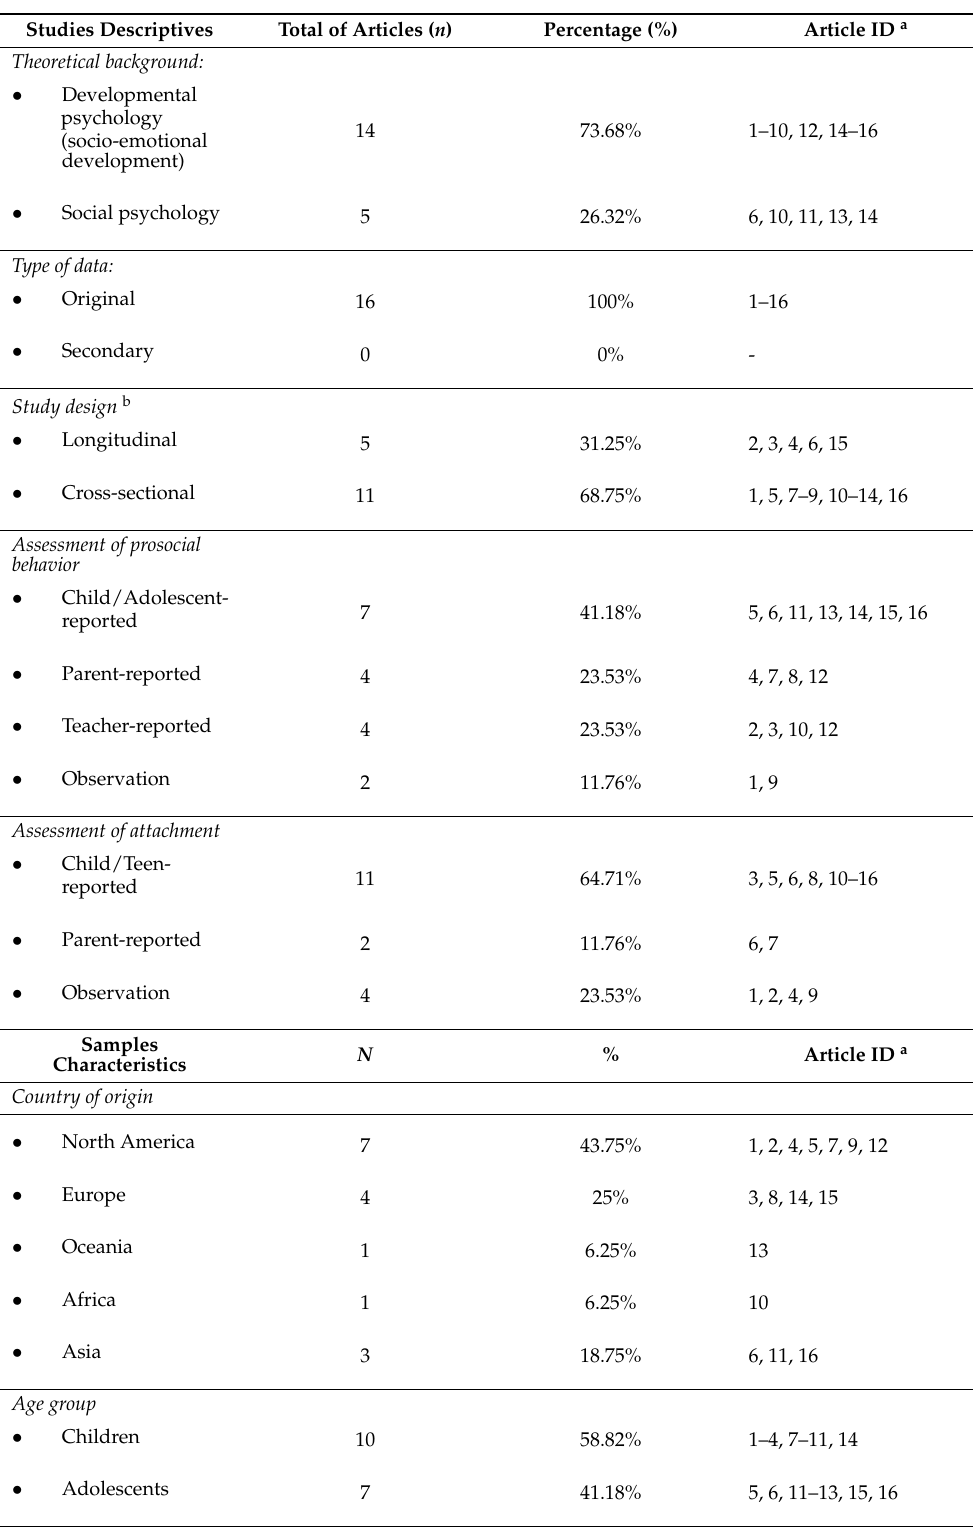
Table 2. Categorization and description of the eligible studies and respective